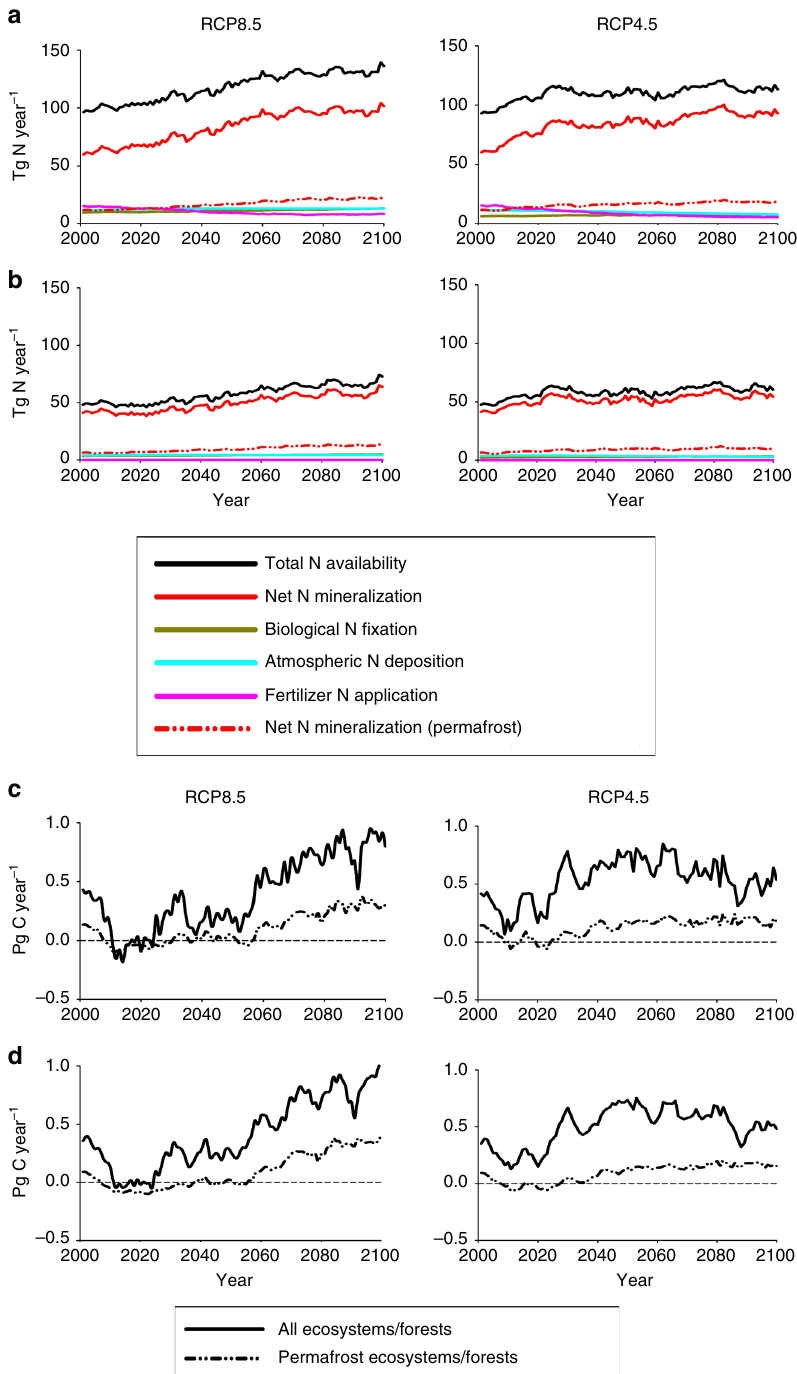
Fig. 4 Temporal trends in annual N availability and annual net C sequestration in Northern Eurasia projected by TEM based on the RCP8.5 and RCP4.5 scenarios during the 21st century. a Trends in total N availability are partitioned by the contributions of net N mineralization, biological N fi xation, atmospheric N deposition, and the application of N fertilizers for all ecosystems. b Same as a , but for all forests. The contribution of net N mineralization for ecosystems and forests underlain by permafrost in 2000 are also shown in a and b , respectively. c Trends in net C sequestration for all ecosystems. d Same as c , but for all forests. Net C sequestration in ecosystems and forests underlain by permafrost in 2000 are also shown in c and d ,